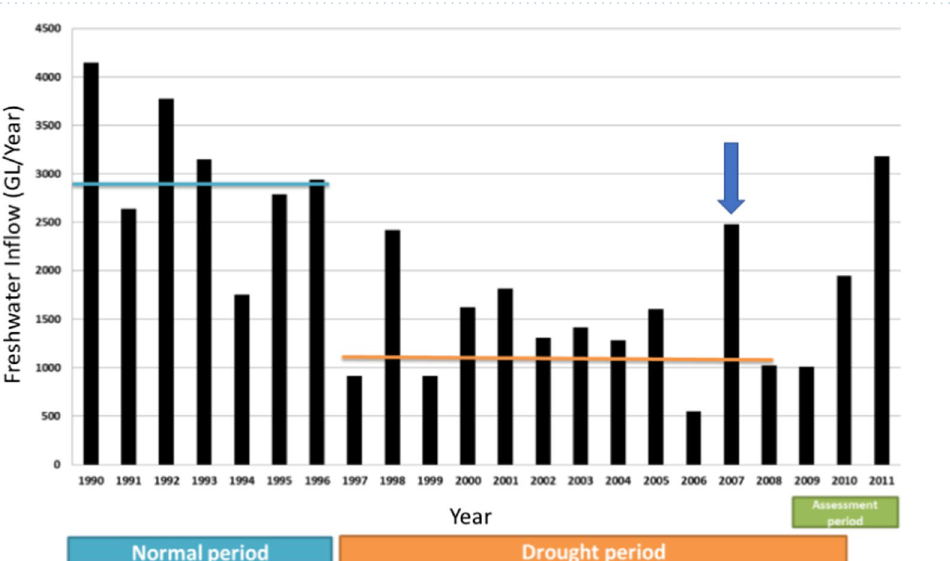
Figure 10. Freshwater inflow to the Gippsland Lakes, Vic., in gigalitres per year (GL/Yr) for 1990 to 2011 showing that the heavy rain of 2007 (arrow) represented an abrupt return to normal inflow after a 10 year period of drought. Source 46